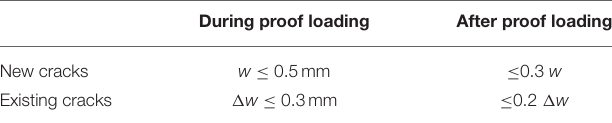
TABLE 1 | Requirements for crack width for newly developing cracks w and increase in crack width for existing cracks 1 w (Deutscher Ausschuss für Stahlbeton,